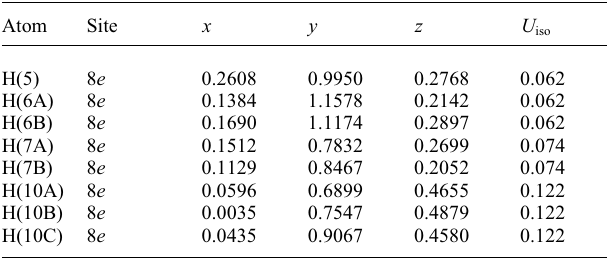
Table 2. Atomic coordinates and displacement parameters (in Å 2 )